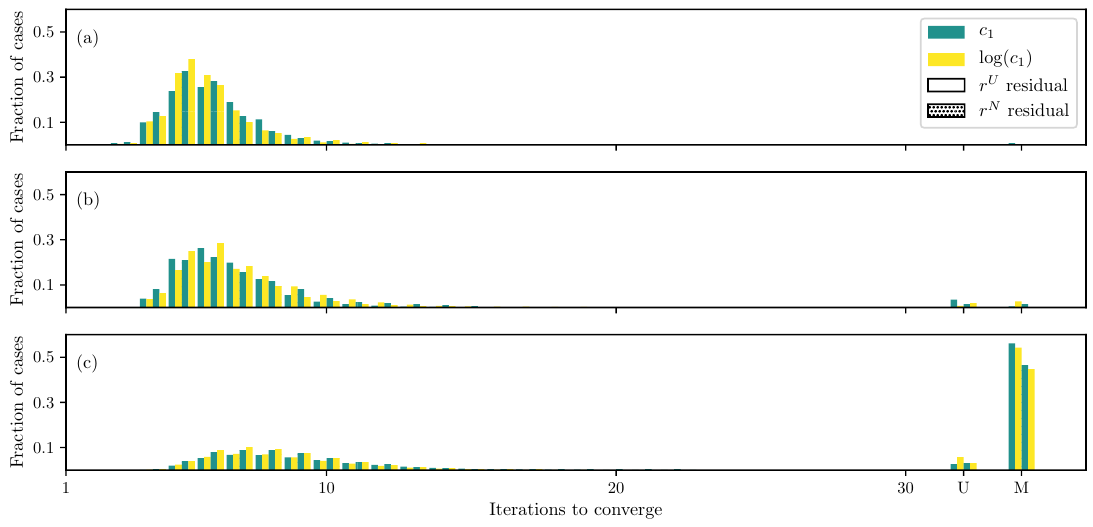
Figure 8. Iterations required using different formulations for the May-Newman model DC case when ( a ) only c 1 and c 2 are unknown, ( b ) all parameters except the fiber angle θ are unknown, and ( c ) all parameters are unknown.